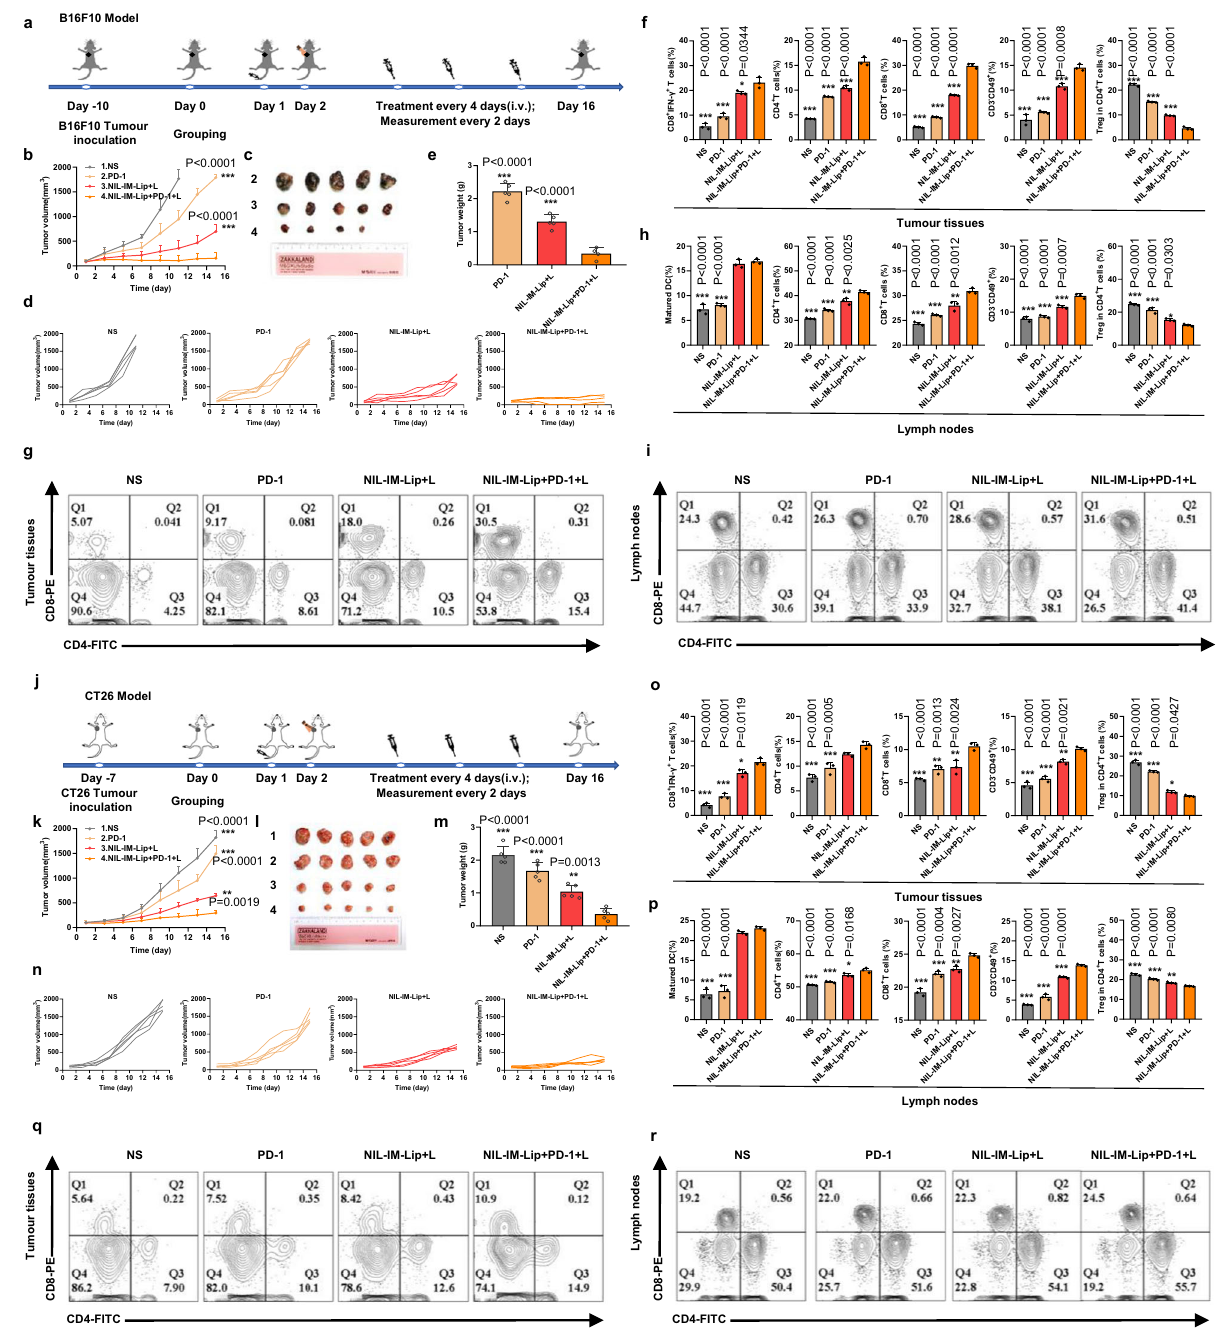
Fig. 8 | Ampli fi ed antitumour effects of NIL-IM-Lip+L and PD − 1 mAb cotreat- ment in hot tumours (B16F10 model) and cold tumours (CT26 model). Mice wereeuthanized when thetumourvolumesreached~2000mm 3 . a Scheduleofthe NIL-IM-Lip+L combined with PD-1 mAb experiment in B16F10 tumour-bearing C57BL/6 mice. b Tumour volume curves of different formulations ( n = 5 biologi- cally independent animals per group). c Photographs of tumours after 16 days of treatment( n = 5biologicallyindependentanimalspergroup). d Individualtumour volume curves after treatment with different formulations ( n = 5 biologically independent animals per group). e Tumour weights in different formulation- treated groups ( n = 5 biologically independent animals per group). f , g Flow cytometric analysis of the intratumoural CTLs, CD4 + T cells and CD8 + T cells, NK cells and Treg cells ( n = 3 biologically independent experiments per group). h , i Flowcytometricanalysisofthein fi ltrationofDCs,CD4 + Tcells,CD8 + Tcells,NK cells and Treg cells in the LNs ( n = 3 biologically independent experiments per group). j Schedule of the NIL-IM-Lip+L combined with PD-1 mAb antitumour